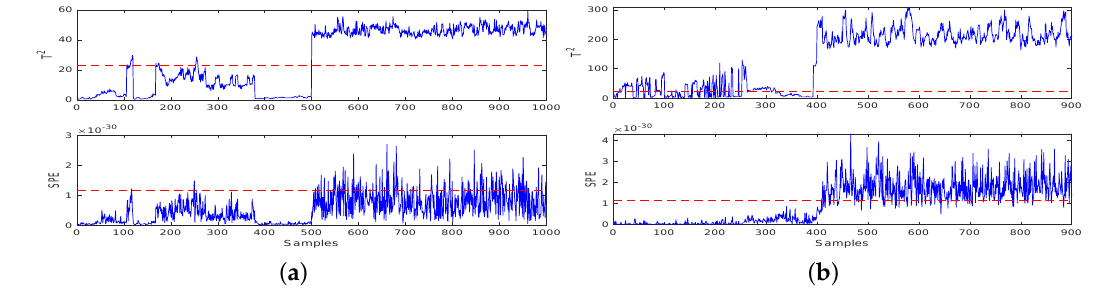
Figure 6. Experiment results of the FD model using PLS. ( a ) Online testing of the FD model using PLS; ( b ) Online testing of the FD model using PLS and JITL.